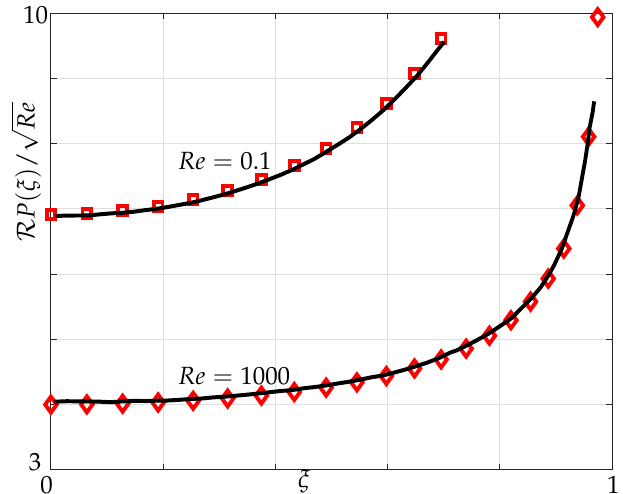
Figure 4. Variation of the real part of pressure difference across the beam for Re = [ 0.1,1000 ] scaled with respect to square root of the Reynolds number; our simulations, Equation (5) (markers), and Tuck’s results (solid lines).